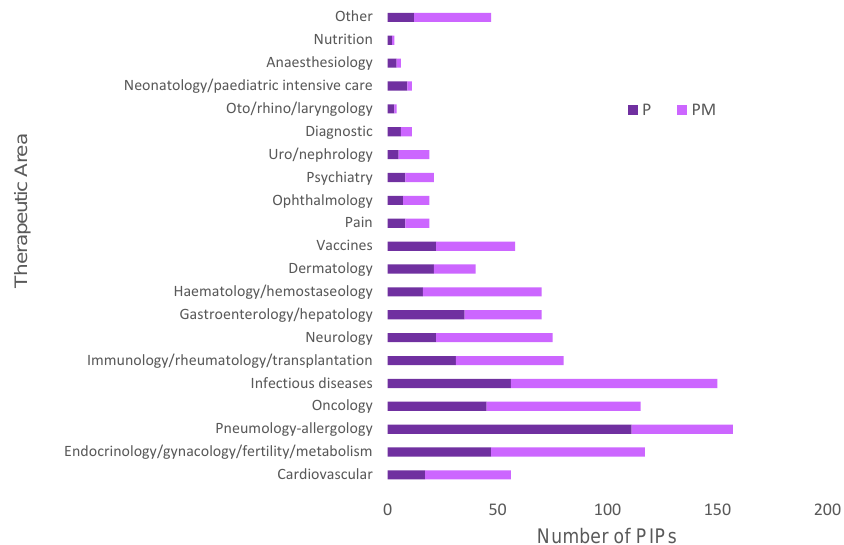
0 Figure 5. Number of positive decisions (P or PM) granted by the PDCO since the establishment of the EUPR in 2007 for the EMA therapeutic areas. Data taken from EMA repository